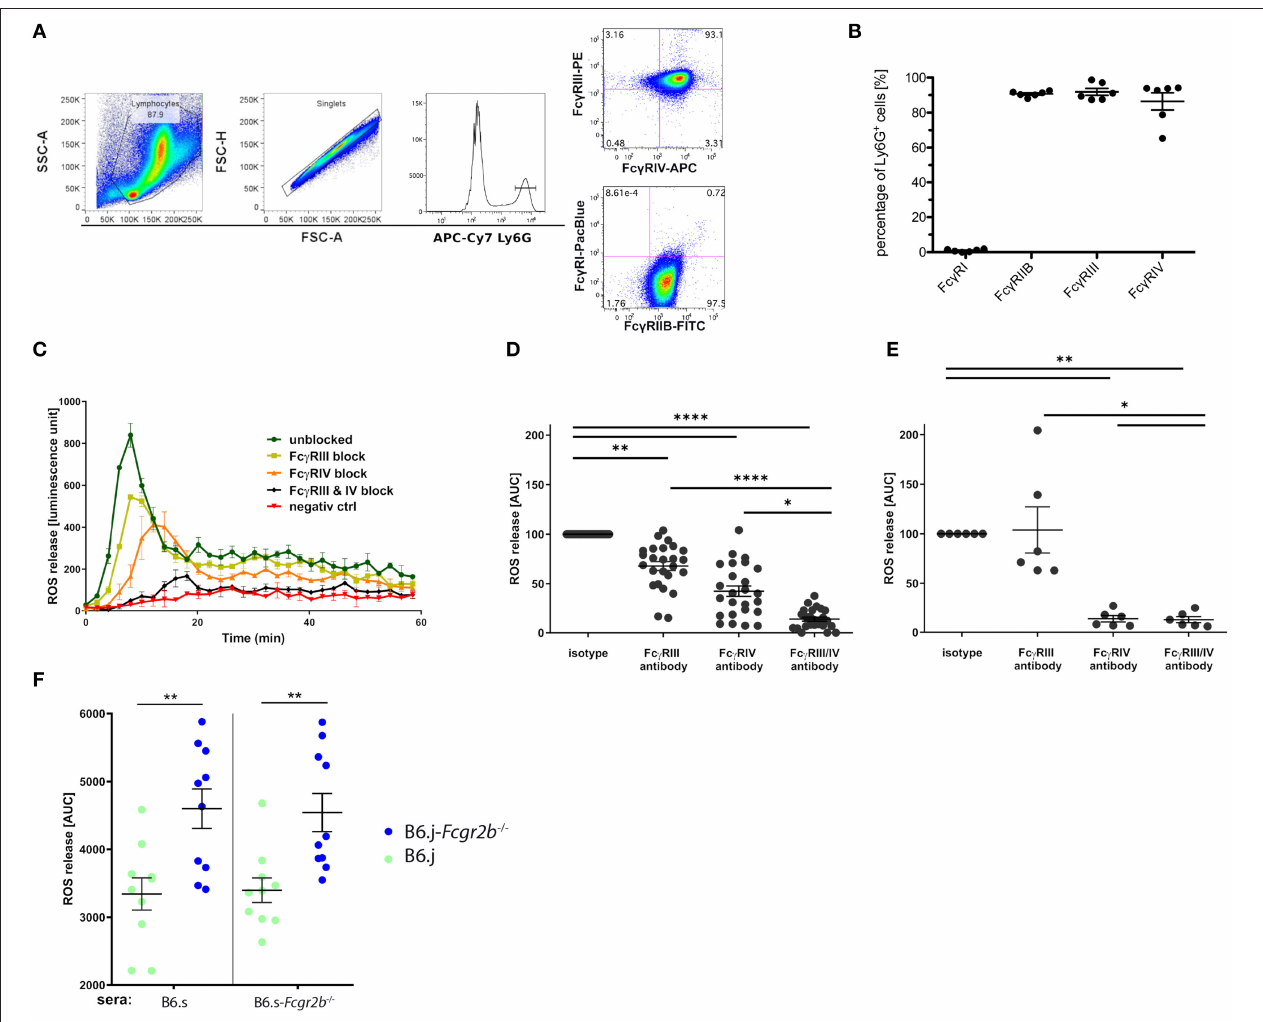
FIGURE 6 | Fc γ R expression in bone marrow neutrophils and impact of vWFA2-specific IgG auto-antibodies on ROS release. (A) Flow cytometric analysis of Fc γ R expression in Ly6G + bone marrow neutrophils. First, bone marrow cells were pregated using the FSC/SSC to exclude cell debris, residual erythrocytes, and lymphocytes, then singlets were excluded via FSC-A/FSC-H gating. In the last step, we gated on Ly6G hi positive neutrophils, which were either stained for Fc γ RIII and Fc γ RIV expression (upper panel) or Fc γ RI and Fc γ RIIB expression (lower panel). (B) Quantitative assessment of Fc γ R expression in bone marrow neutrophils. High expression of Fc γ RIIB, Fc γ RIII, and Fc γ RIV (90.7 ± 1.4%; 98.4 ± 4.4%, and 86.43 ± 9.9%, respectively) but almost no Fc γ RI expression (0,96% ± 0,6%) in Ly6G + neutrophils; n = 6/group, scatter blot with mean ± SEM. (C) ROS release from bone marrow neutrophils in response to sera from immunized wt B6.s mice (week 4) in the presence or absence of individual or combined Fc γ RIII/Fc γ RIV targeting. The graph is representative of 9 independent experiments. (D) Impact of Fc γ RIII and/or Fc γ RIV targeting on immune serum-driven ROS release from wt bone marrow neutrophils.; n = 25/group. Data are shown as scatter blot with mean ± SEM. The immune sera were from immunized wt B6.s mice (week 4). A non-parametric One-way ANOVA was used to determine significant differences and post-hoc Dunn’s multiple comparison test to assess differences between individual groups (* p < 0.05; ** p < 0.001; **** p < 0.0001). (E) Impact of Fc γ RIII and/or Fc γ RIV targeting on immune serum-driven ROS release from wt bone marrow neutrophils. The immune sera were taken from rabbits immunized with vWFA2, n = 6/group. Data shown are scattered dot blot with mean ± SEM (* p < 0.05; ** p < 0.01) (F) Potency of sera from B6.s and B6.s- Fcgr2b − / − mice to induce ROS release from B6.s wt (green) or B6.s- Fcgr2b − / − (blue) neutrophils. Neutrophils from B6.j- Fcgr2b − / − mice produced more ROS than those from wt B6.s mice in response to sera from either B6.s or B6.s- Fcgr2b − / − mice. n = 10 / group. Data shown are scattered dot blot with mean ± SEM. Unpaired Mann–Whitney test was used to determine significant differences between groups (** p <